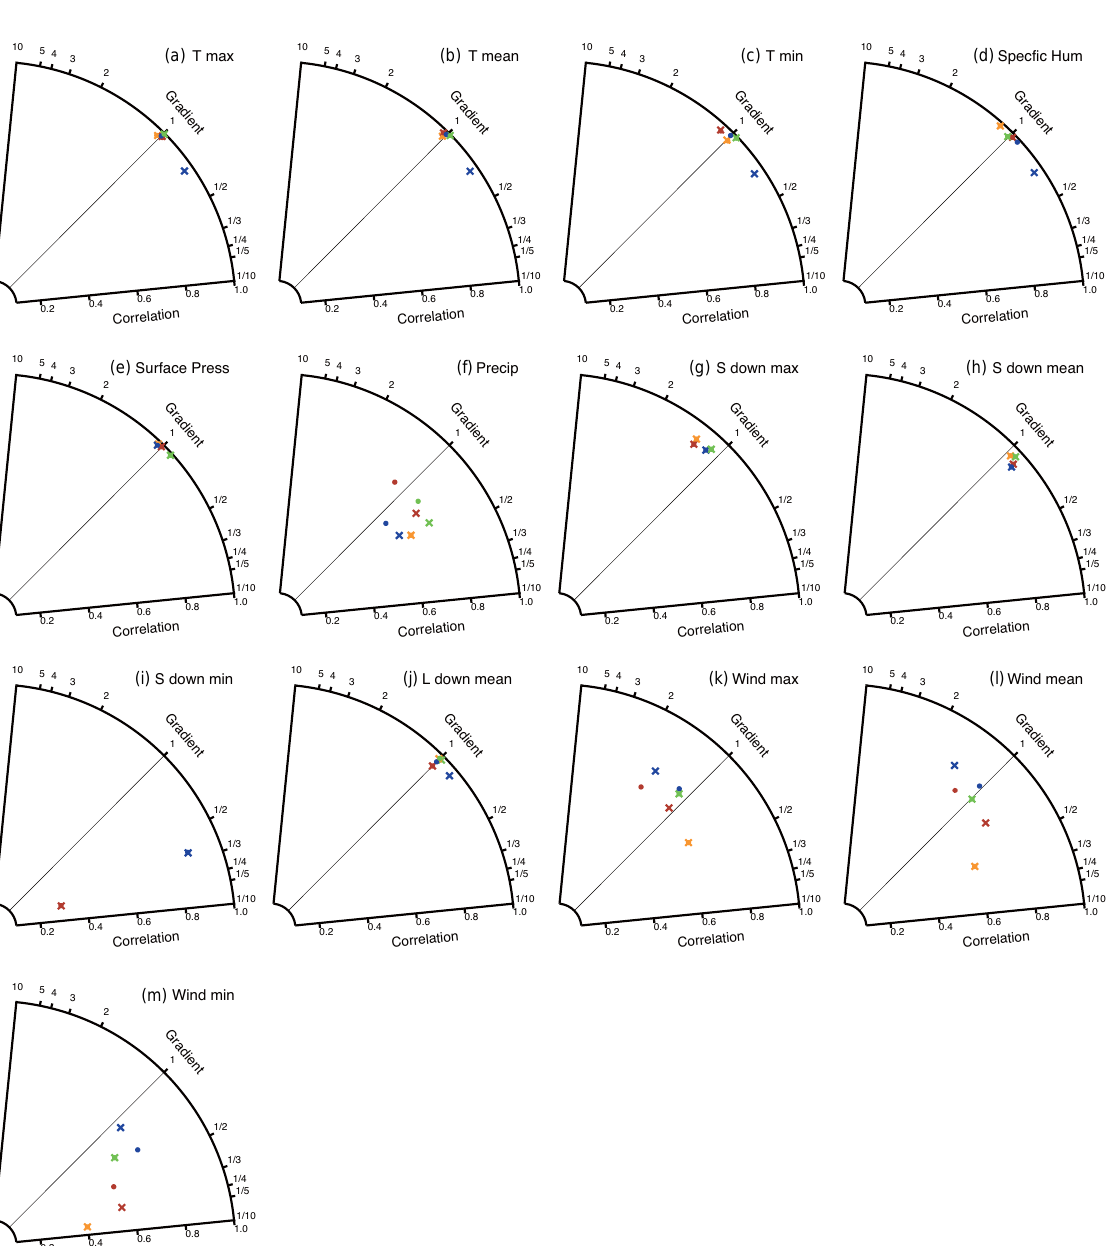
Lv1 = 0 . 98 × Lv0 + 17 (Yakutsk)